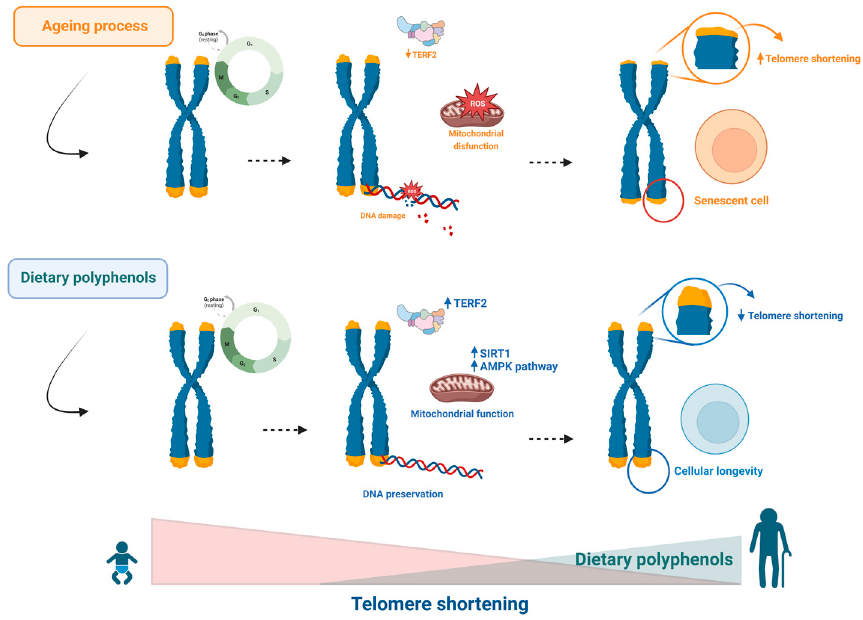
Figure 3. Telomere shortening contributes to ageing. Short telomeres lead to mitochondrial DNA damage, inducing senescence. Dietary polyphenols can protect against ageing by modulating each step in this sequence.